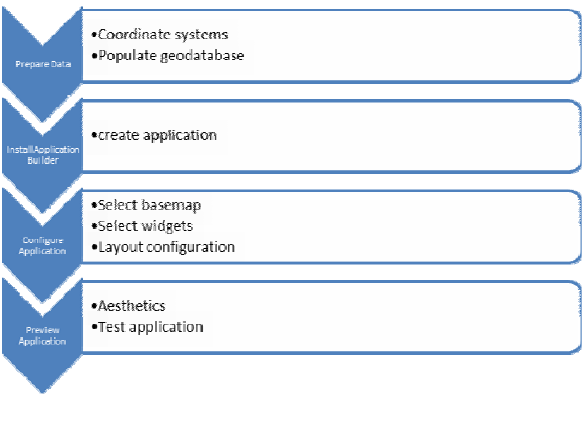
Figure 4. Web map implementation process